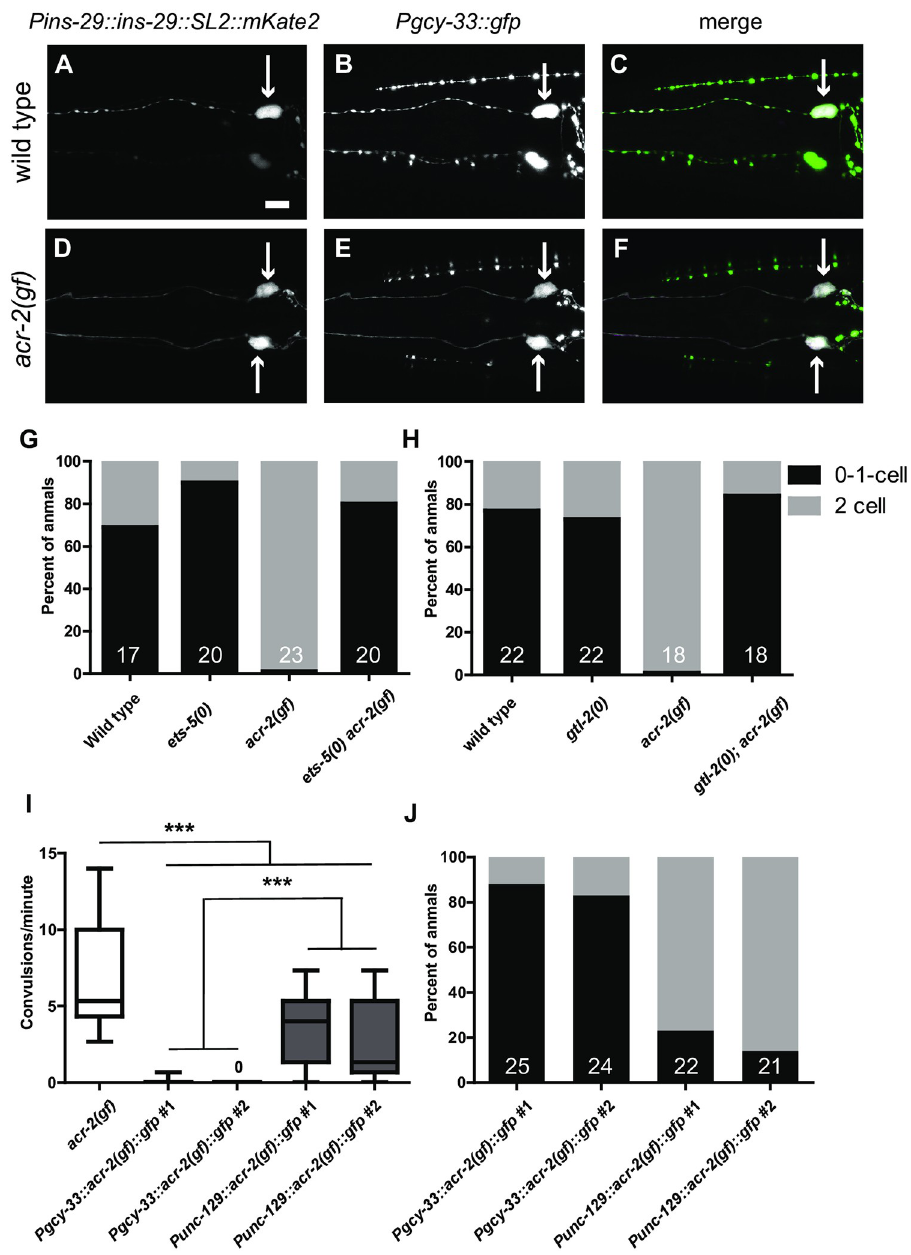
Fig 4. ins-29 is expressed in BAG neurons and is regulated by motor circuit activity. A-F. Pins-29 reporter is expressed in BAG neurons. Cell bodies expressing indicated reporters are labeled by an arrow. (A) In wild type animals, expression of Pins-29 :: ins-29 :: SL2 :: mKate2 in a single neuron in the head is shown. This reporter is often not expressed at all or in a single neuron in wild type, similar to the transcriptional GFP reporter (B) Pgcy-33 :: gfp labels BAG neurons in the head. (C) Overlap between the two reporters can be observed in one neuron in wild type. (D) Expression of Pins-29 :: ins-29 :: SL2 :: mKate2 is observed in two head neurons in acr-2(gf) , similar to the transcriptional GFP reporter. (E) Expression of Pgcy-33 :: gfp in acr-2(gf) is similar to wild type in acr-2(gf) . (F) Complete overlap is observed between the two reporters in acr-2(gf) . GFP-only signal is from the Pmec-4 :: gfp co-injection marker. Scale bar:10 μ m. In all images, animals are rolled in 10% agarose to facilitate visualization of BAG neuron pairs. Beading observed in some images (i.e. the Pgcy-33 :: gfp and Pmec-4 :: gfp in B) is due to the mounting procedure. G. Almost all acr-2(gf) animals express Pins-29 :: gfp(juEx7742) in both BAG neurons, however mutation of ets-5 causes animals to exhibit more similar Pins-29 :: gfp expression patterns as wild type. To assay Pins-29 :: gfp expression, animals were scored for detectable GFP in 0, 1, or 2 BAG neurons. N for each genotype is labeled in the bar. H. Loss-of-function of